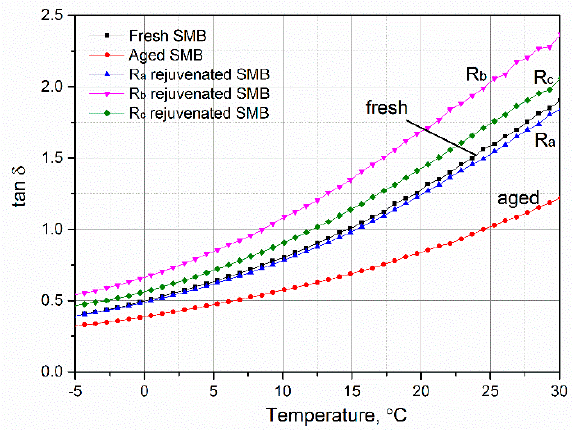
Figure 6. Effect of rejuvenating systems on the loss tangent of aged SMB.